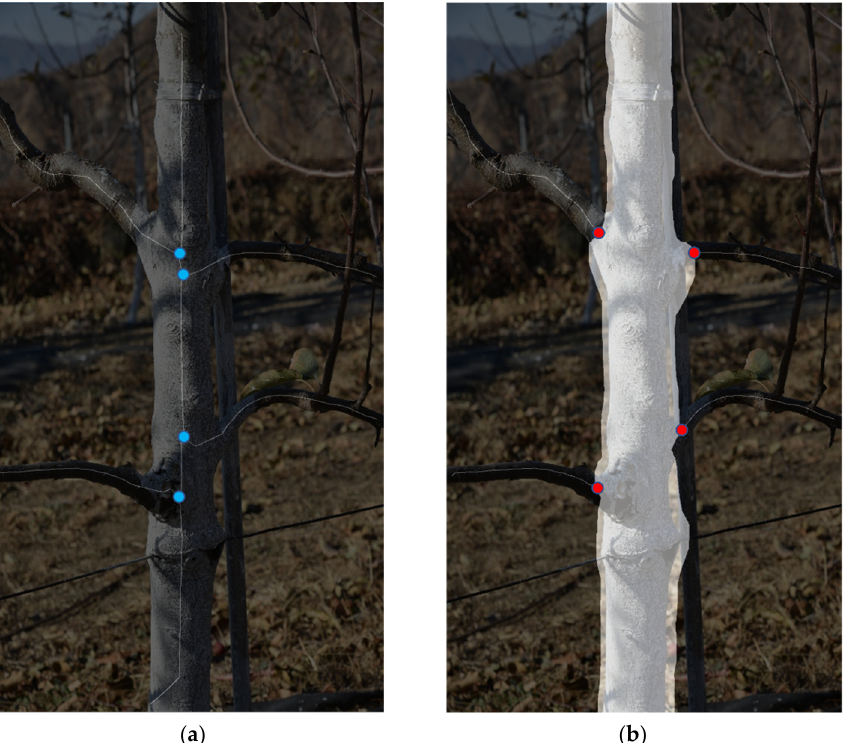
Figure 12. Comparison between two skeleton extraction methods and actual apple tree: ( a ) comparison of the skeleton and junction points of the apple tree directly processed by Zhang & Suen with those of actual apple tree; ( b ) comparison between skeleton and junction points obtained by Cascade Mask R-CNN SW-T combined with Zhang & Suen and those of the actual apple tree.